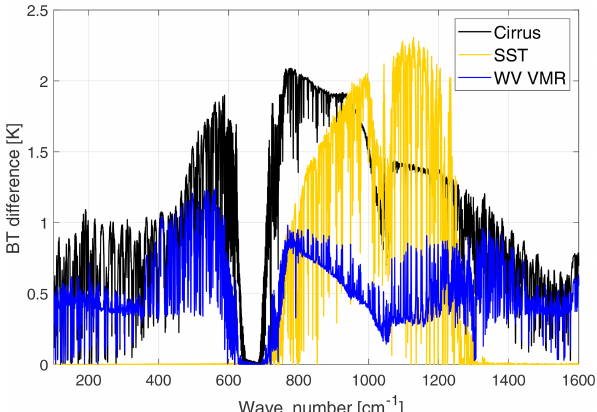
Figure 2. Brightness temperature (BT) sensitivity to a sub-visible cirrus cloud (black line), a 3K decrease in surface temperature (yel- low line) and an increase of 10% in water vapour mixing ratio at all levels (blue line). The BT differences are obtained in reference to a tropical clear-sky case over the ocean.